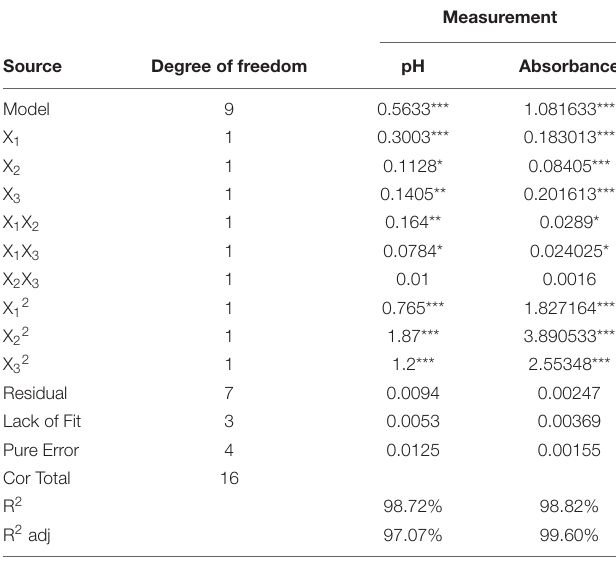
TABLE 2 | Analysis of variance related to pH and absorbance data obtained from the Box Behnken